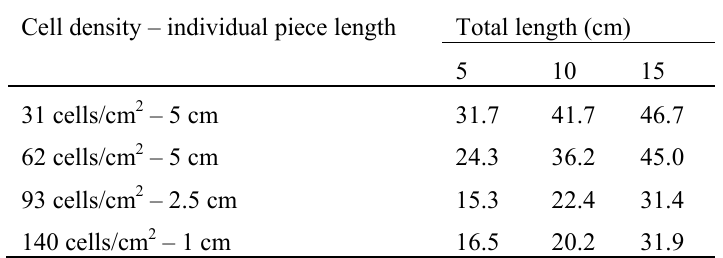
Table 4. Breakthrough profile width t from